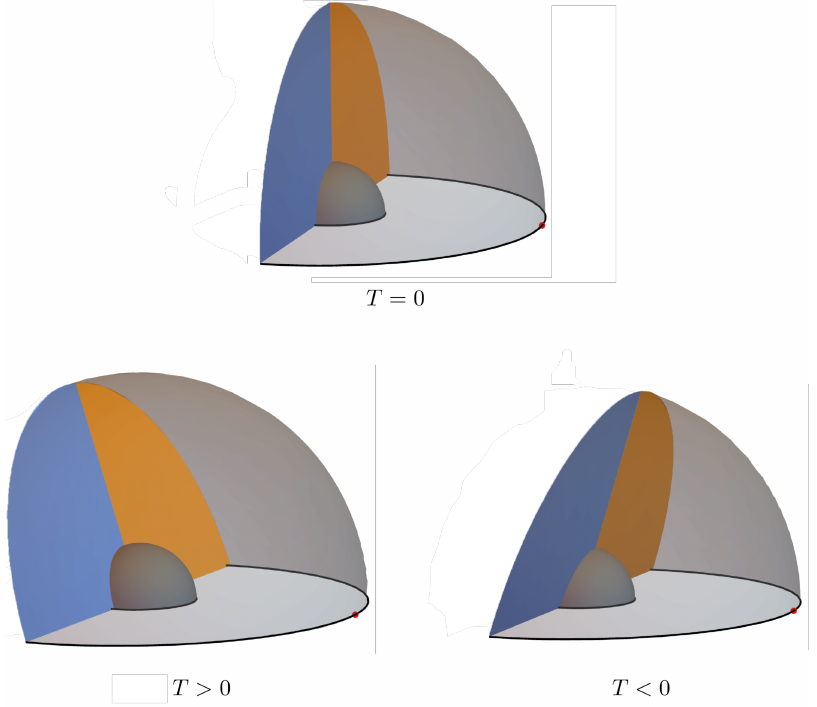
Figure 26 . Bulk domain for the thermal AdS 3 phase in Poincaré coordinates. For zero tension the domain is given by half of the region in between two concentric hemispheres centered in the origin and of radii r = exp(2 π 2 /h ) and r = exp( − 2 π 2 /h ) . The surfaces of the two hemispheres are out in identified. The brane consists of the half annulus in the < ( ξ ) − η plane cutting in half the region in between the hemispheres. The portion of the brane shaded in orange corresponds to the portion of the brane extending from { z = 0 , x = 0 } to the turning point in thermal AdS coordinates (i.e. 3 ( z ) ), while the portion of the brane shaded in blue represents the portion of the brane extending x + th from the turning point to { z = 0 , x = h } (i.e. x − ( z ) ). The addition of positive (negative) tension th causes the bulk domain to increase (decrease) as the brane tilts towards positive (negative) values √ of = ( ξ ) . The brane sits in the plane identified by = ( ξ ) = ( T/ 1 − R 2 T 2 ) η . For critical positive tension, the whole region in between the emispheres is recovered, and for negative critical tension the bulk domain approaches the empty